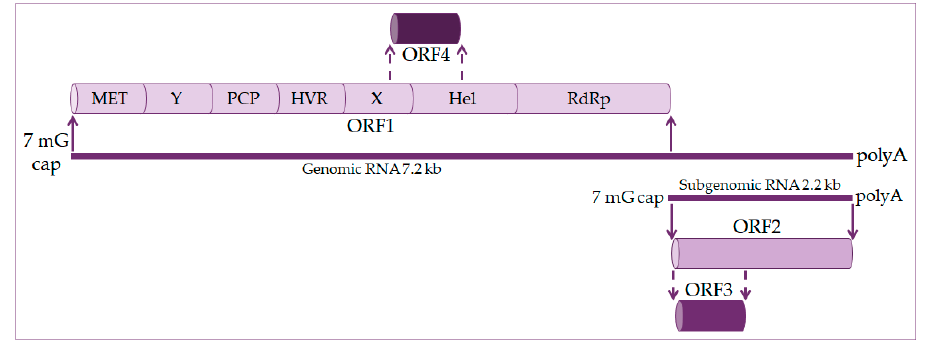
Figure 1. Hepatitis E virus genome organization. The genome is 7.2 kb positive-strand RNA with a 5 ′ 7-methylguanosine cap (7 mG cap) and a 3 ′ polyadenylated tail (polyA). It harbors four open reading frames (ORF). ORF1 codes nonstructural proteins, including a methyltransferase (MET), an RNA helicase (Hel), and an RNA-dependent RNA polymerase (RdRp), as well as less well-characterized domains, such as the Y domain, a papain-like cysteine protease (PCP), a hypervariable region (HVR), and the X domain. ORF2 and ORF3 encode the viral capsid and a small protein involved in virus secretion, respectively, translated from a 2.2 kb subgenomic RNA generated during viral replication. The ORF4 is found in the HEV-1 genotype and codes protein enhanced viral replication.